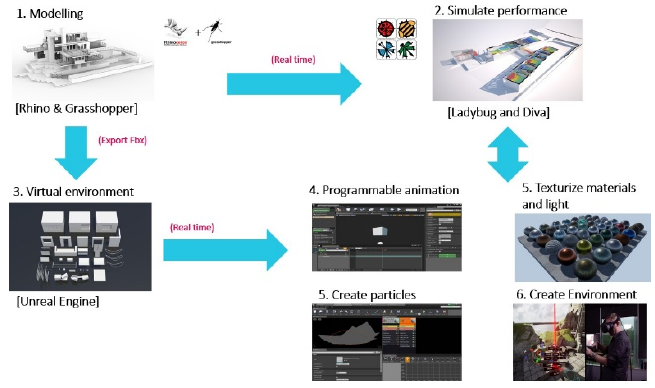
Figure 14. Modeling and Virtual Reality Workflow.